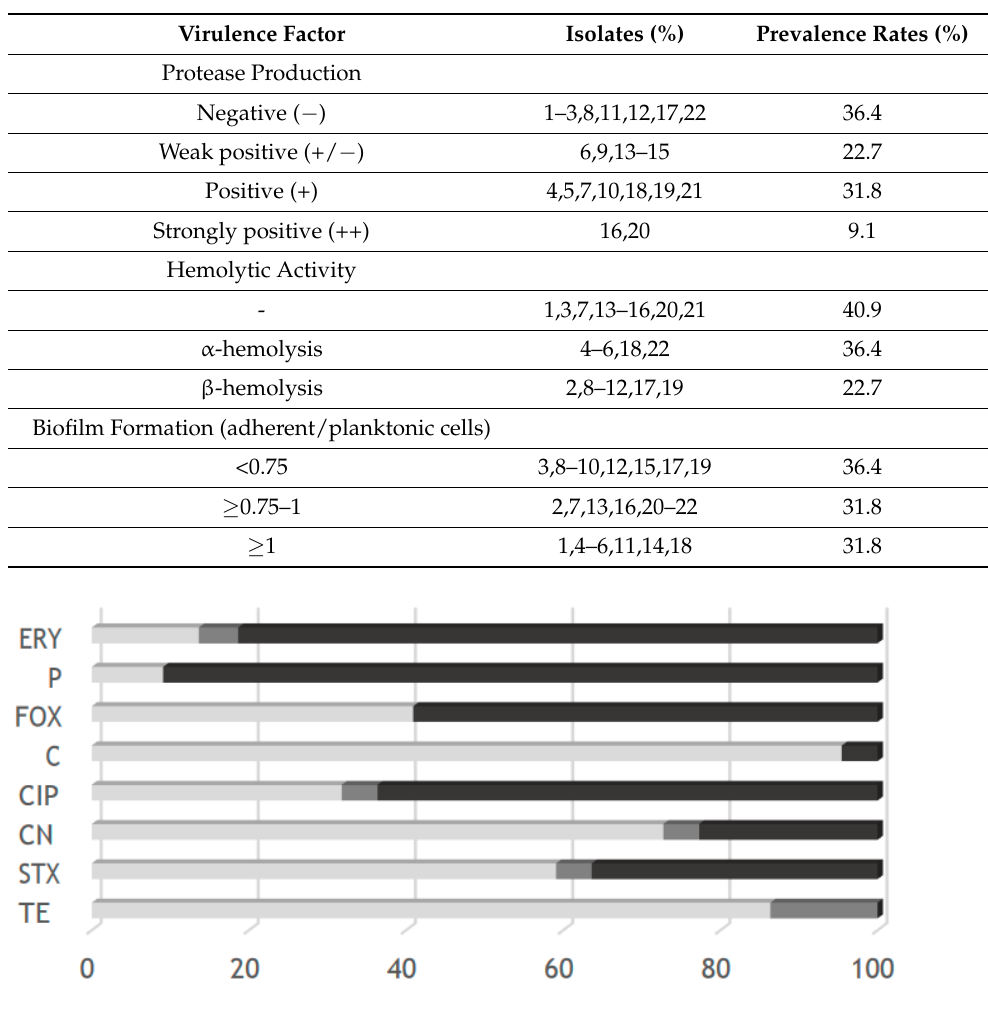
Table 2. Virulence factors in Staphylococcus isolates: proteolytic, hemolytic activity, and biofilm formation.